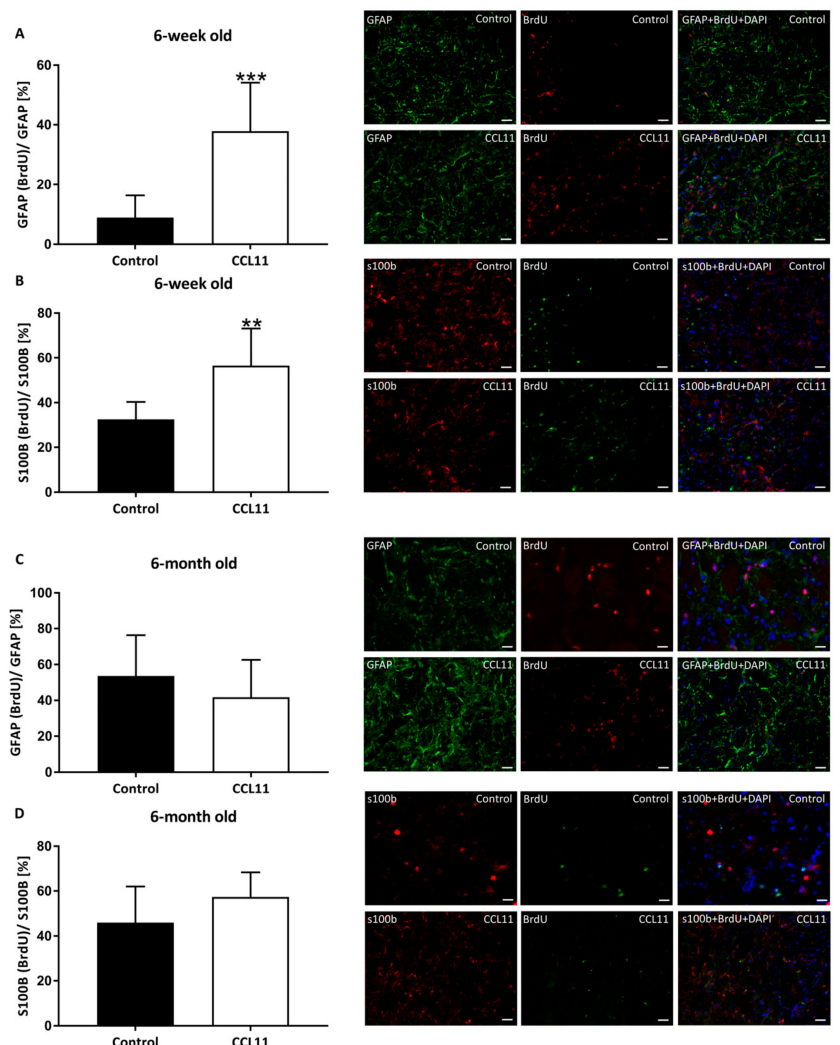
Figure 5. CCL11 promotes post-stroke gliogenesis in adolescent mice. C57BL6 male mice were subjected to cerebral ischemia for 45 min followed by reperfusion for 28 d. At the beginning of the reperfusion, mice received intraperitoneal injections of either 10 µ g / kg bodyweight of CCL11 or 100 µ L of PBS as control followed by daily injections on the seven consecutive days after reperfusion. BrdU was injected from day 8 to day 18. Gliogenesis was evaluated by co-expression analysis of the glial markers together with BrdU as counted in 5 ROIs in both adolescent ( A , B ) and adult ( C , D ) mice. Figure ( A ) shows GFAP and BrdU co-localized cells, ***significantly di ff erent from the corresponding control, p = 0.0005. Figure ( B ) shows s100b and BrdU co-localized cells, **significantly di ff erent from the corresponding control, p = 0.004. In Figure ( C ) GFAP and BrdU co-localized cells are depicted, ns p = 0.329. Figure ( D ) displays s100b and BrdU co-localized cells, ns p = 0.137. Photographs depicted beside each diagram show representative stainings for each experimental condition. n = 8 in the CCL11 group and n = 10 in the control group of adolescent mice. n = 6 in the CCL11 group and n = 7 in the control group of adult mice. All data are given as means ± S.D., scale bars 20 µ